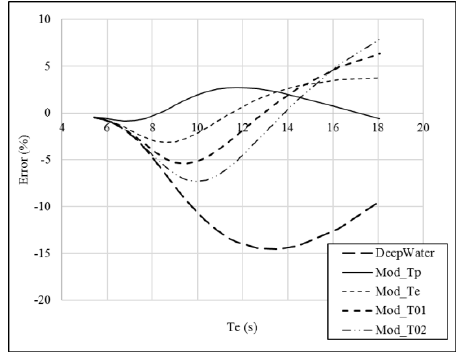
Figure 13. Errors for deep-water formulas and modifications using different periods ( h = 50 m).